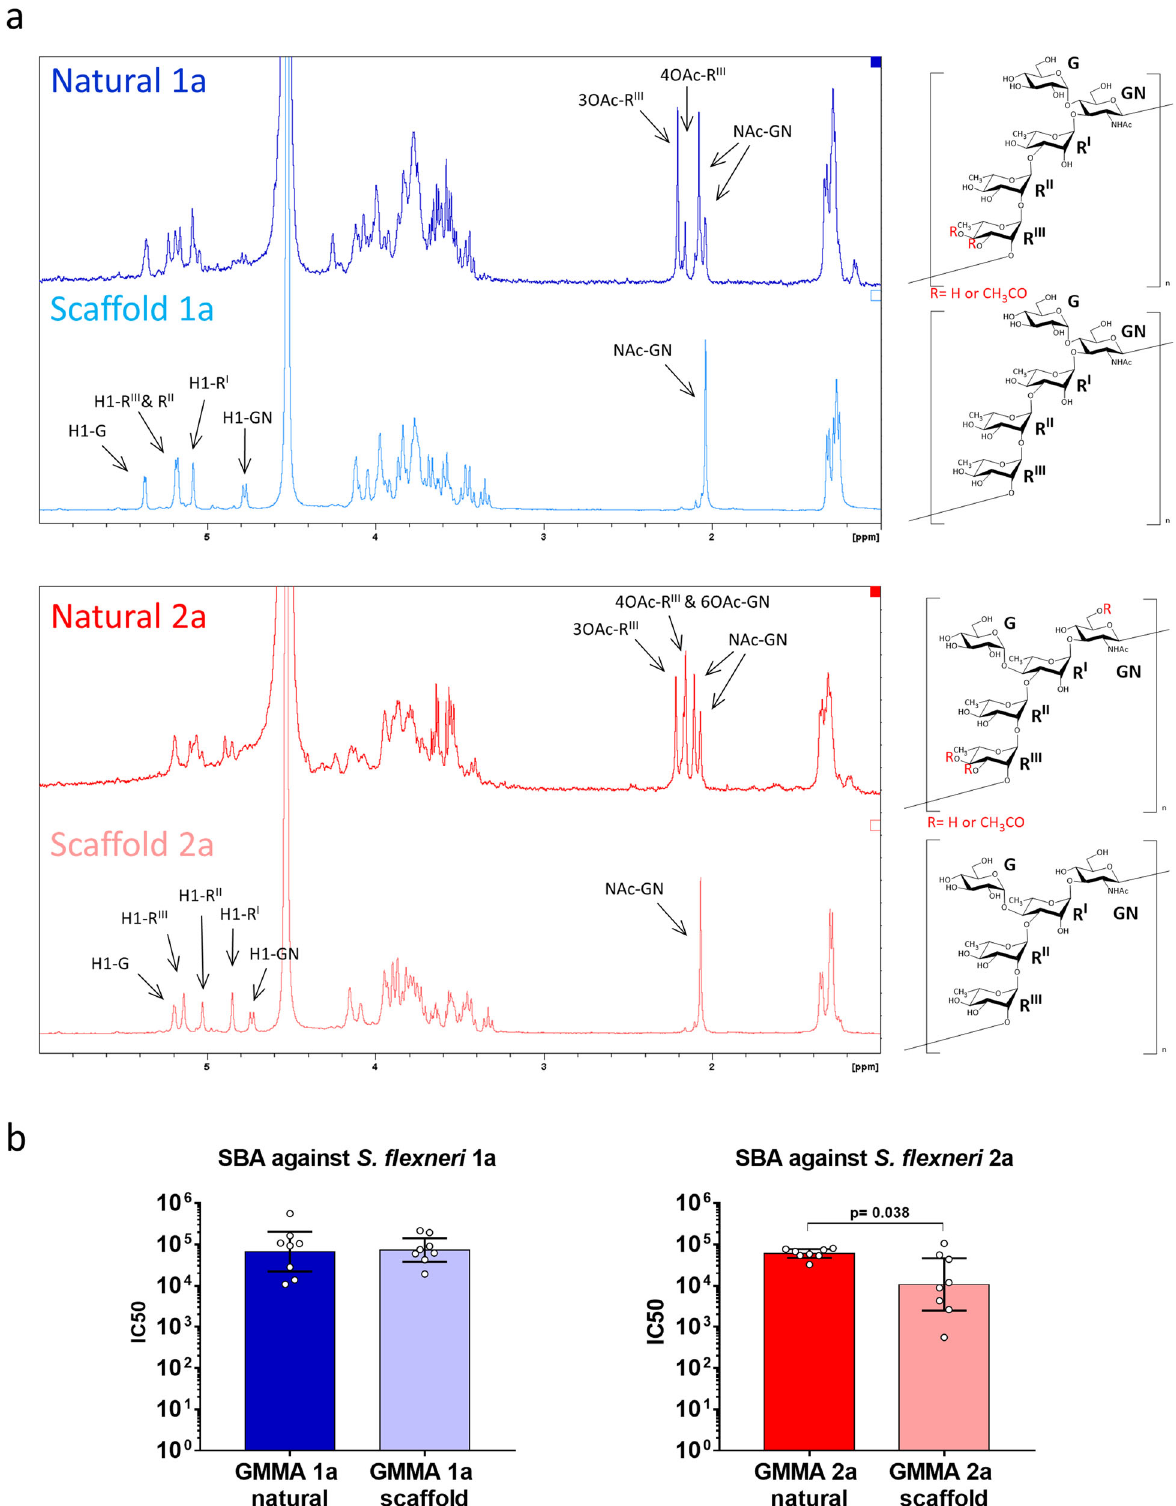
Fig. 2 Analytical and immunological comparison between GMMA from the converted scaffold strains and GMMA from the corresponding natural strains. a 1 H-NMR spectra of OAg isolated from GMMA. Chemical shifts were assigned in the anomeric and O-acetyl regions (R = Rhamnose; GN = N-Acetyl Gucosamine; G = Glucose). b Bactericidal activity of sera raised in mice against the different GMMA. Serum dilutions able to kill 50% of bacteria in the assay (IC 50 ) are reported for individual mice (dots), error bars represent 95% con fi dence